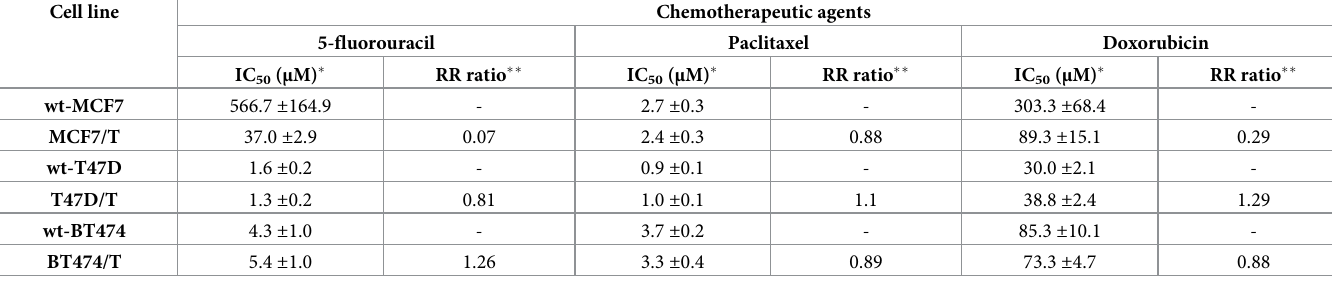
Table 2. IC 50 values for 5-fluorouracil, paclitaxel, and doxorubicin for wild-type and tamoxifen-resistant sublines. Cell